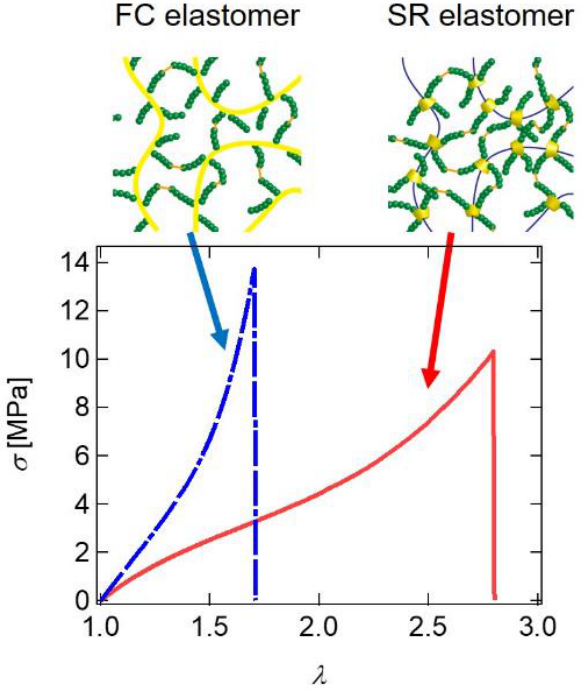
Figure 21. Stress – extension ratio curves of FC and SR elastomers. Reprinted from [36] with permis- sion from Elsevier.